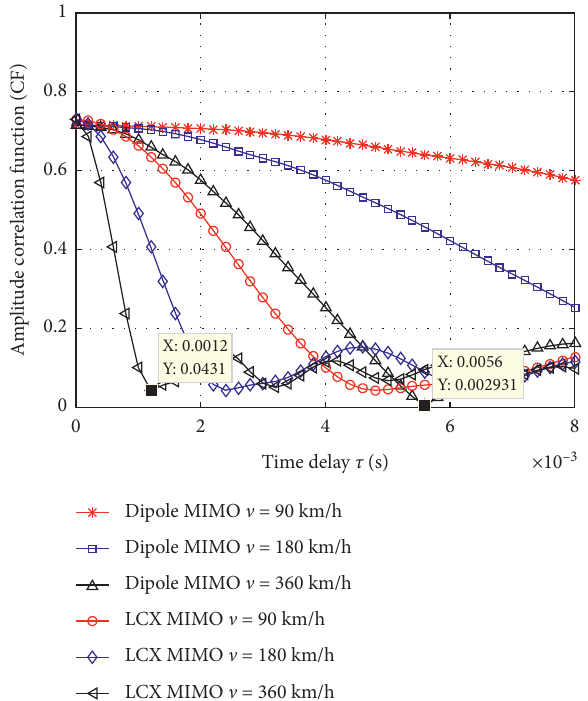
Figure 4: Amplitude correlation function (CF: LoS+NLoS) comparison between dipoles MIMO and LCX-MIMO for different velocity with different time delays ( t � 0s, d � 0.7 λ , Region 2).